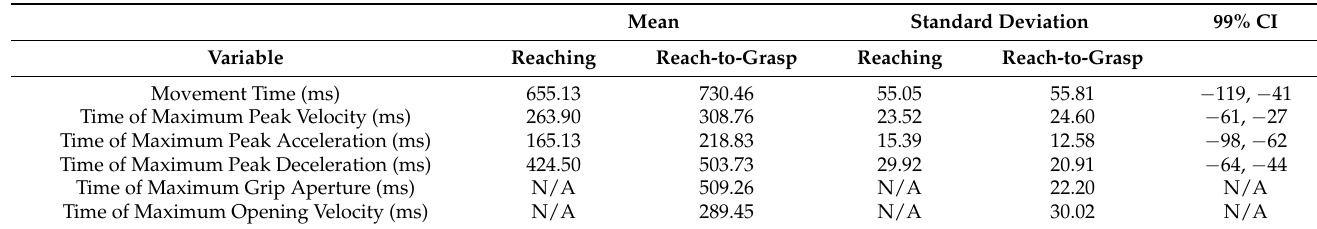
Table 1. Mean, standard deviation and Confidence Intervals (CI) for the considered kinematic measures. Statistics comparing the two types of movement are also included.